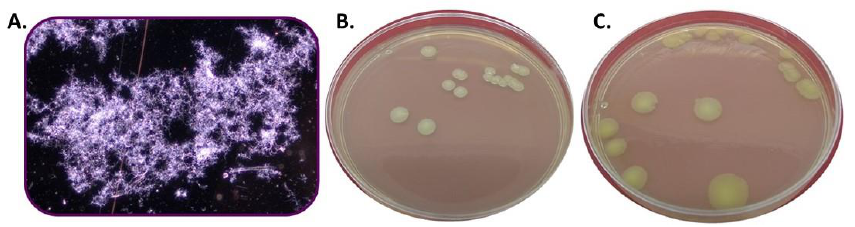
Figure 4. Streptomyces CDBB1232 . ( A ) Viable mycelium grown in YGM liquid culture (100× microscope view). ( B ) Colonial morphology of a viable culture; ( C ) Colonial morphology of a non-viable culture.